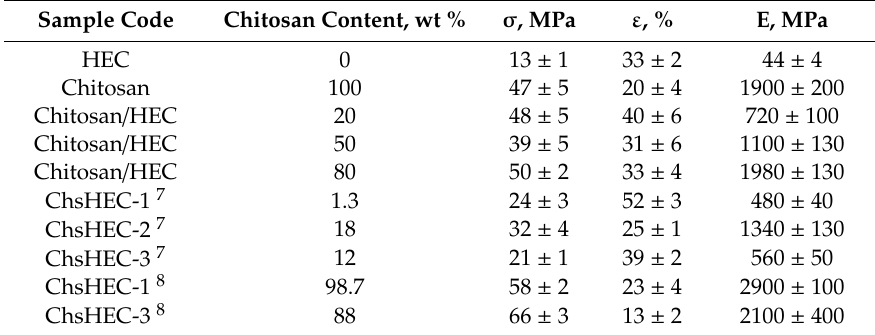
Table 4. Characteristics of composite chitosan/HEC films and the films cast from various fractions of the ChsHEC copolymers.